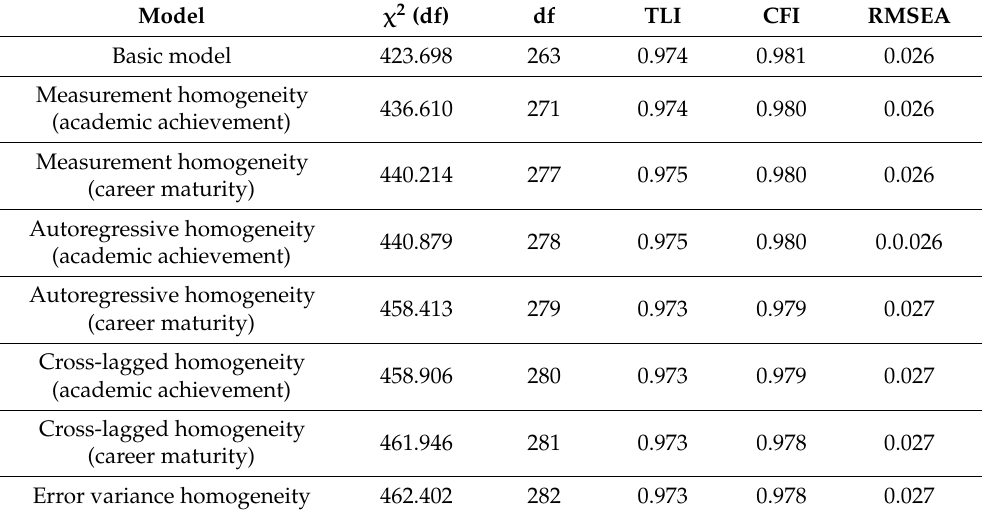
Table 3. The fitness of research